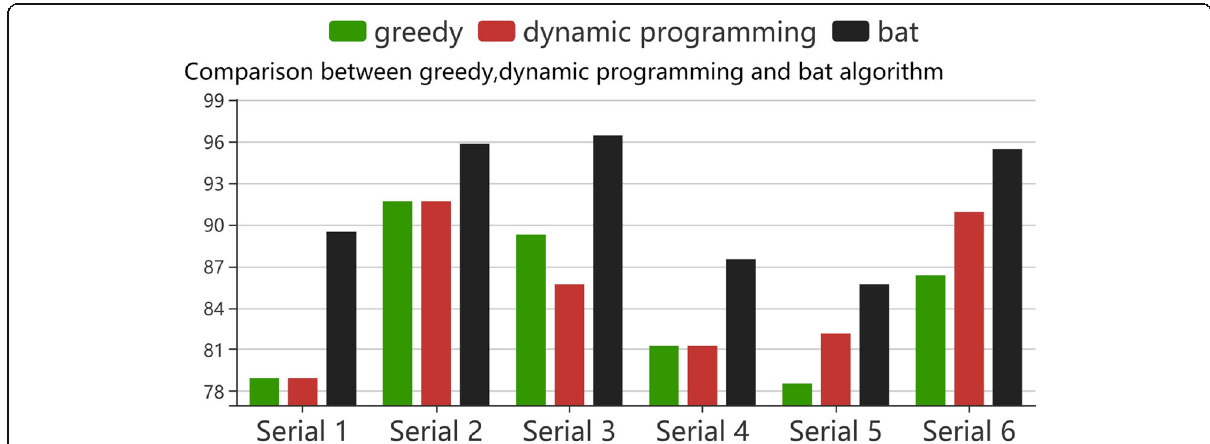
Fig. 3 Comparison of results between greedy, dynamic programming, and bat algorithm — bar chart. The optimal solution, greedy solution, and the solution of the discrete bat algorithm can be calculated for each set of data. In Fig. 3, the vertical axis represents the correct rate and the horizontal axis represents the same meaning in Fig. 2. It can be concluded that results for each data obtained by greedy algorithm and dynamic programming algorithm are relatively similar, but they all get lower ratio of idle network than that of bat algorithm. The bat algorithm has achieved better results than greedy algorithm and dynamic programming algorithm for each set of data, and results of bat algorithm achieves higher ratio of idle network occpied by request